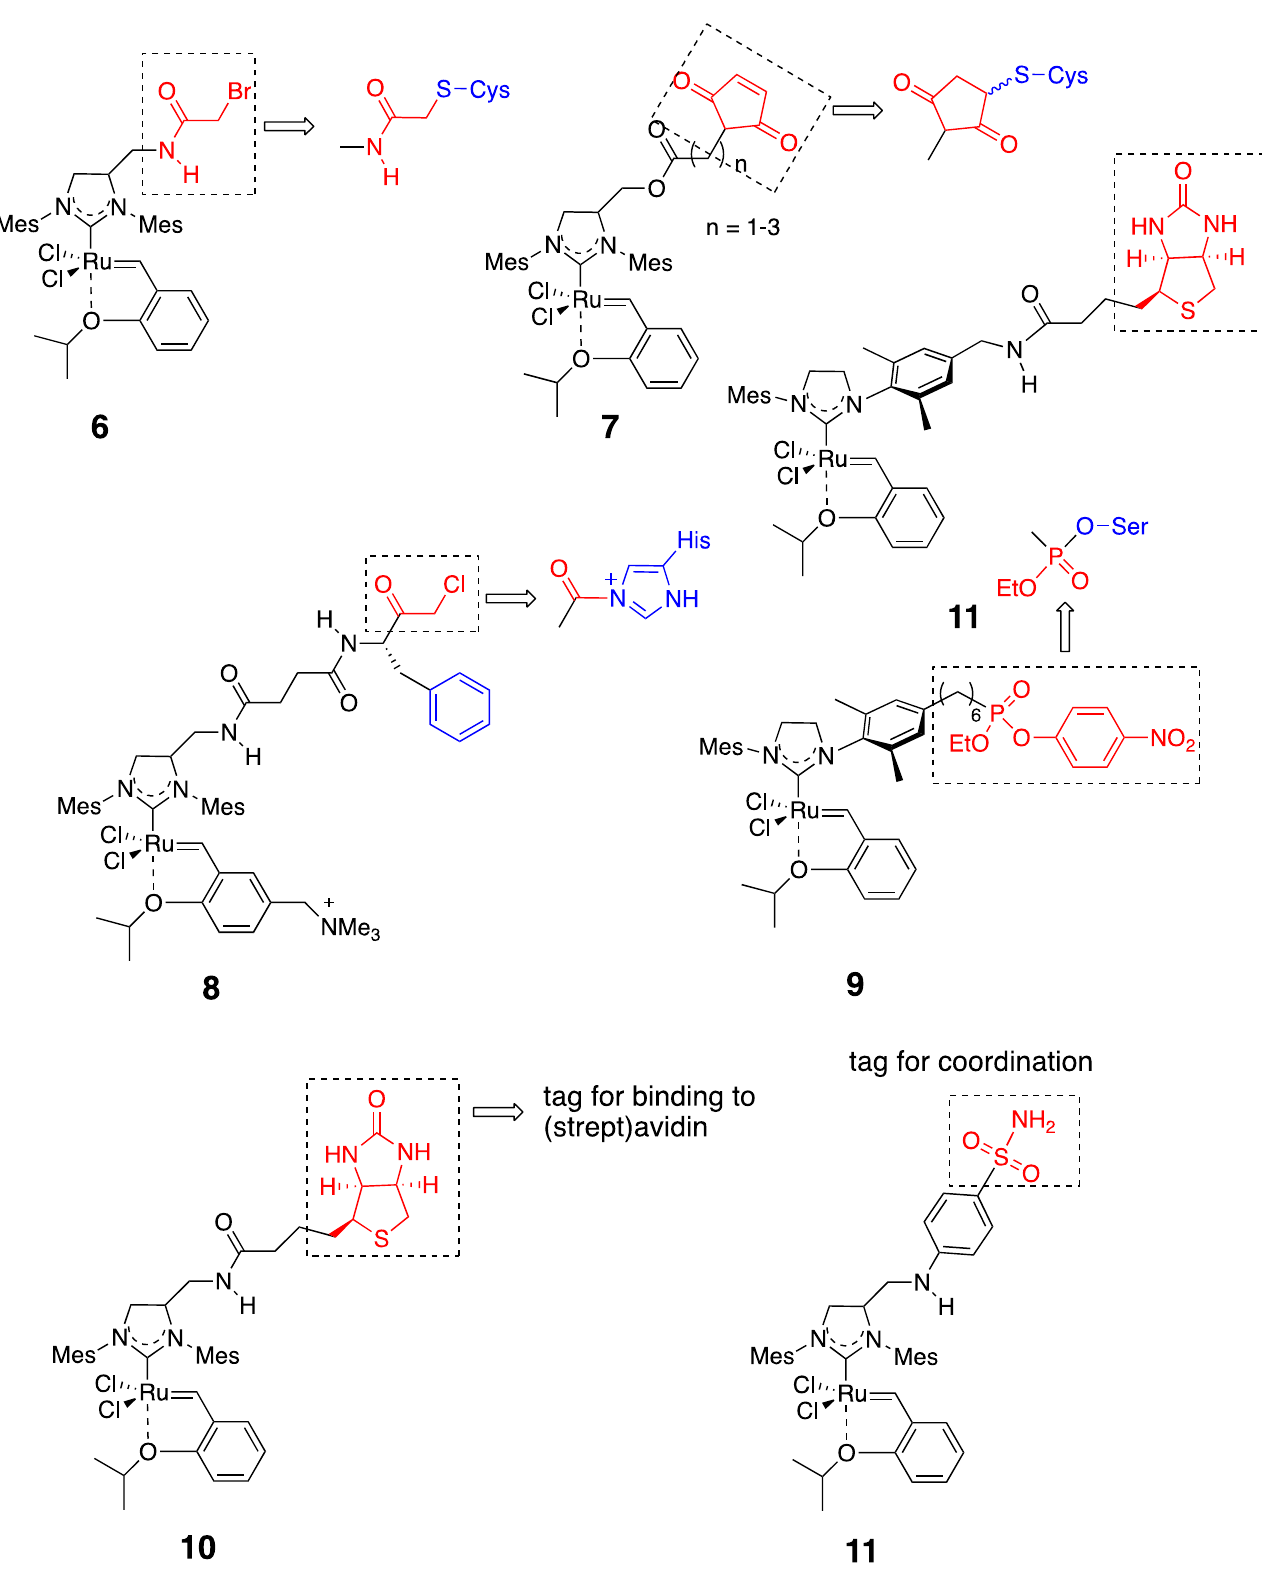
Figure 4. HG-II-type complexes used for the construction of hybrid artificial metalloenzymes with olefin metathesis activity (OM-ArMs) [24].